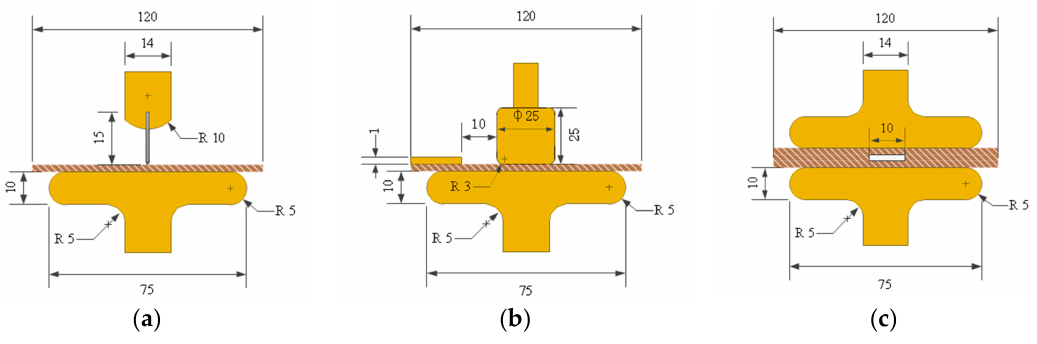
Figure 2. Schematic diagram of the electrodes. ( a ) Needle-plate; ( b ) Surface discharge; ( c ) Air gap.